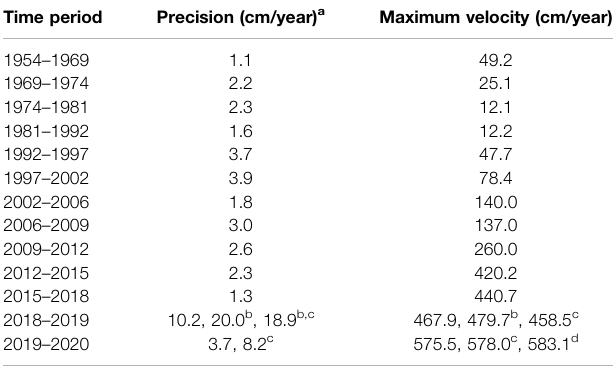
TABLE 4 | Summary of the computed surface